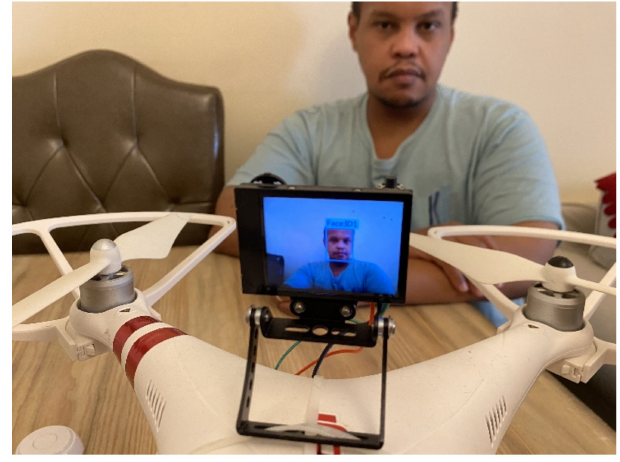
Figure 2. Facial recognition to identify specific user on the medical delivery drone.